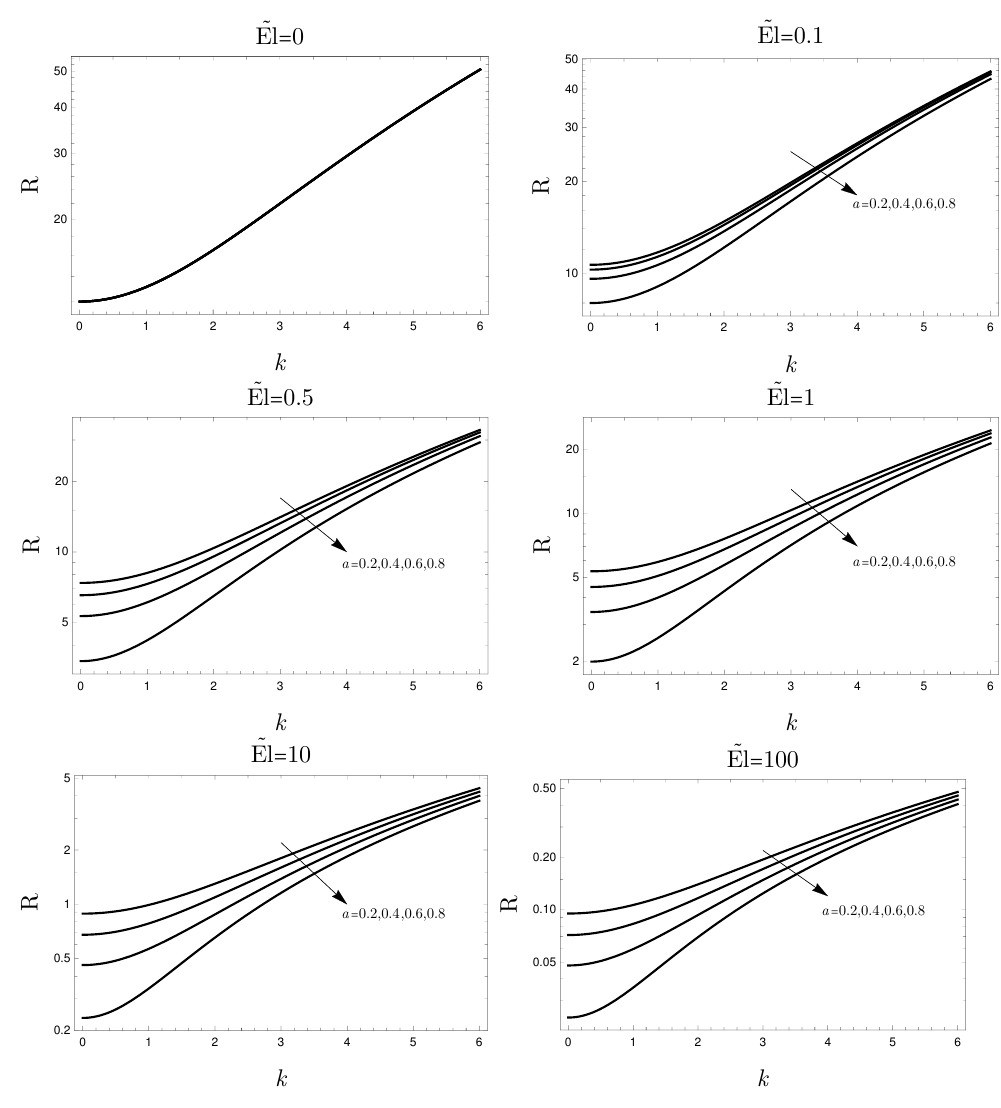
Figure 2. Neutral stability condition for different values of El and ˜ a .